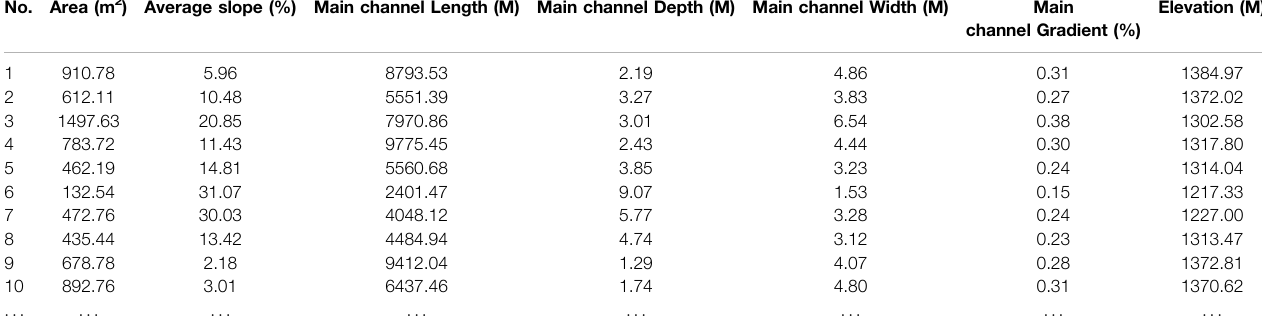
TABLE 1 | Characteristic value of 10 sub